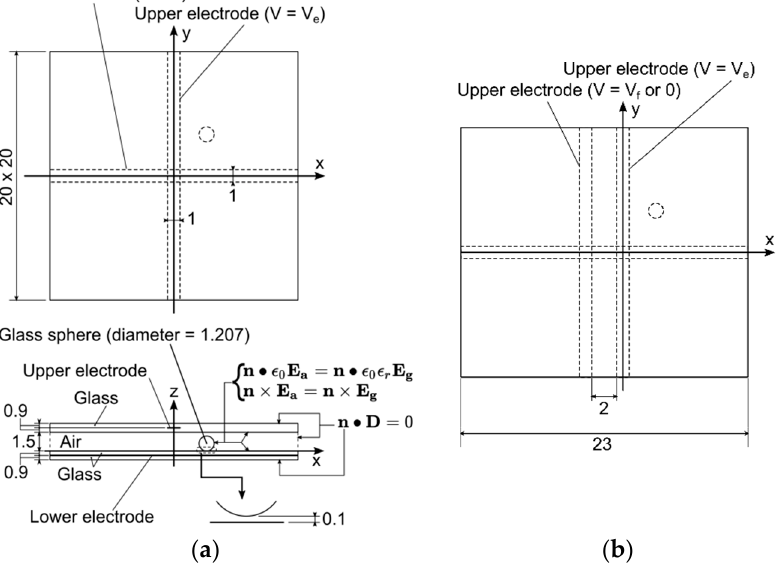
Figure 5. Calculation region (dimensions are all in mm): ( a ) Top and side views of the region for single-cross-point type; ( b ) Top view of the region for dual-cross-point type.